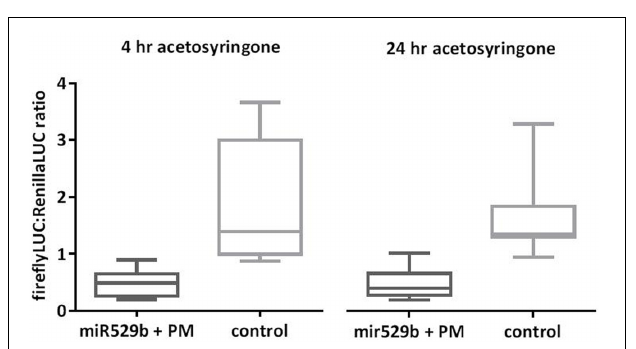
FIGURE 6 | Comparison of 4 h versus 24 h acetosyringone incubation periods. Increasing the incubation period of Agrobacterium cultures from 4 to 24 h post-addition of acetosyringone did not enhance the mi529b-directed knockdown of reporter-target expression. The controls consist of assays where the miR529b precursor culture was replaced with a precursor construct culture that does not target the miR529b PM sequence. Error bars represent SDs ( n =